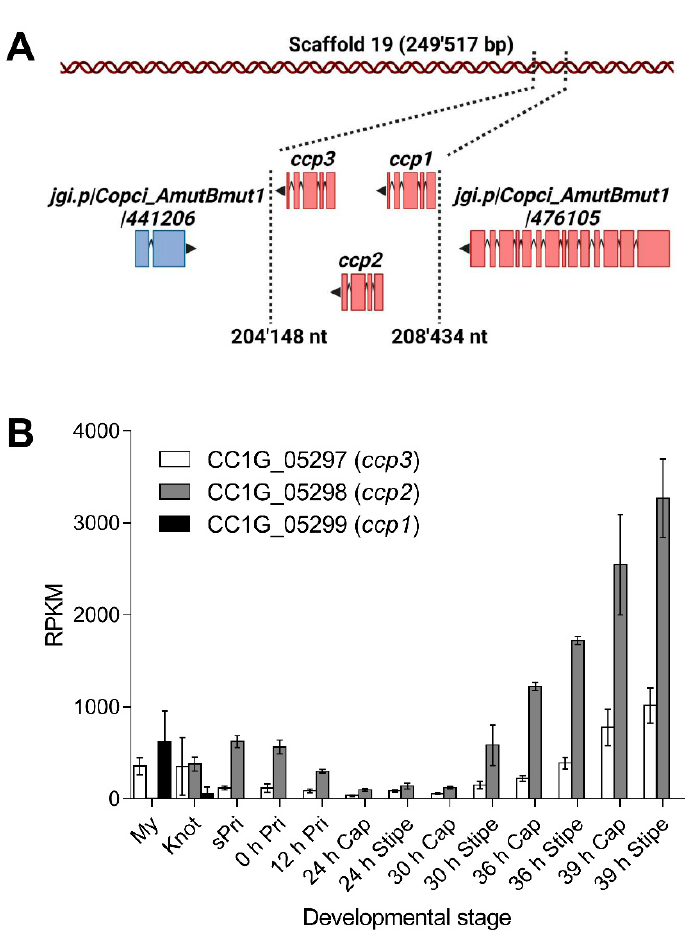
Figure 1. Cocaprin-encoding genes form a tandem array in the genome of C. cinerea strain AmutBmut and show developmental regulation. ( A ) Representation of the cocaprin locus on scaffold 19 with arrowhead and colors indicating the direction of transcription. Boxes show the location of exons; ( B ) Mean RPKM (Reads Per Kilobase of transcript per Million mapped reads, n = 2) corresponding to 13 developmental stages in C. cinerea strain AmutBmut for ccp1 , ccp2 and ccp3 [17]. Standard deviations are shown as error bars. My: Vegetative mycelium, Knot: Hyphal knots with vegetative mycelium, sPri: Small fruiting body primordia, 0 h Pri: Fruiting body primordia at 0 h, 12 h Pri: Fruiting body primordia at 12 h after the trigger light, 24 h Cap: Cap at 24 h after the trigger light, 24 h Stipe: Stipe at 24 h after the trigger light, 30 h Cap: Cap at 30 h after the trigger light, 30 h Stipe: Stipe at 30 h after the trigger light, 36 h Cap: Cap at 36 r after the trigger light, 36 h Stipe: Stipe at 36 h after the trigger light, 39 h Cap: Cap at 39 h after the trigger light and 39 h Stipe: Stipe at 39 h after the trigger light.